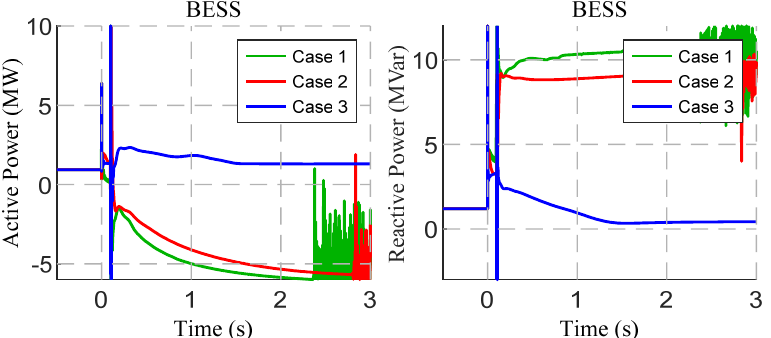
Figure 17. BESS power converter active and reactive power outputs for different reactive current- voltage injection profiles.